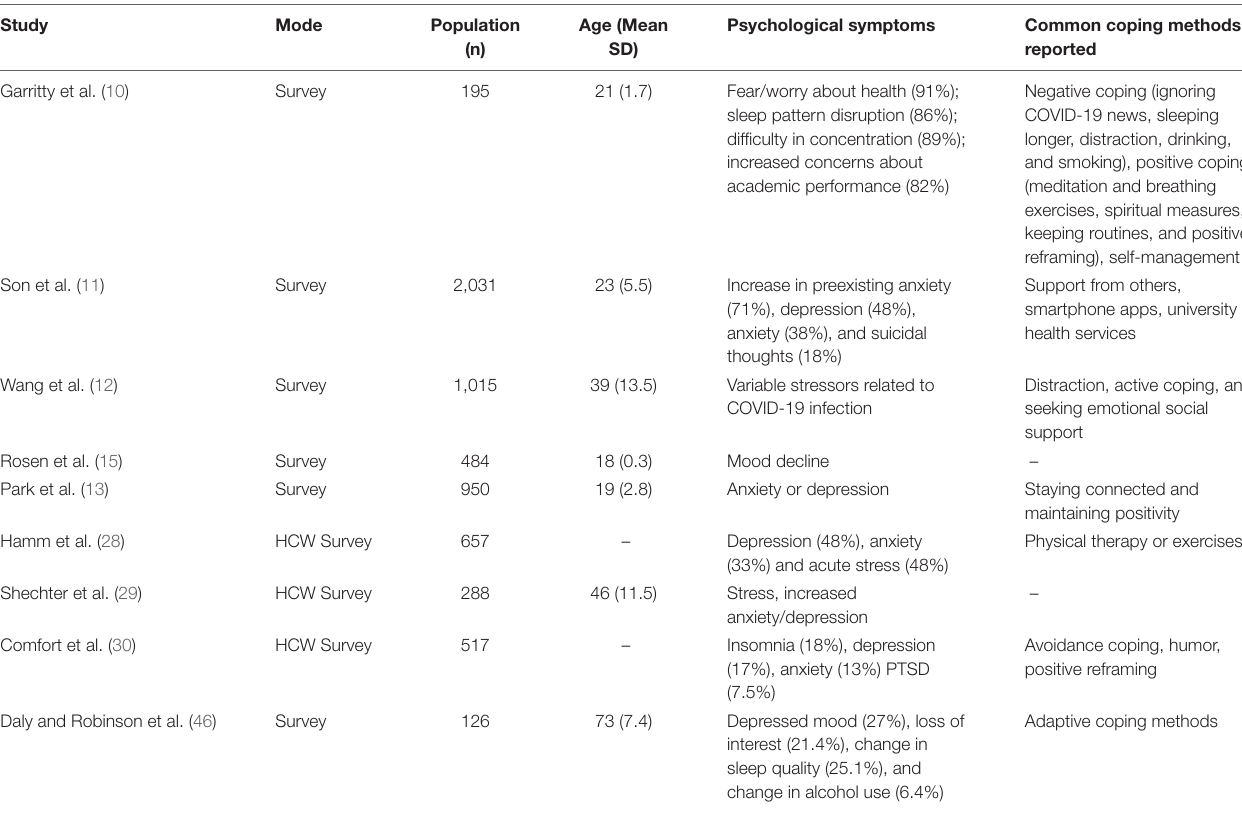
TABLE 1 | An overview of the included studies on child and adolescent, and HCWs